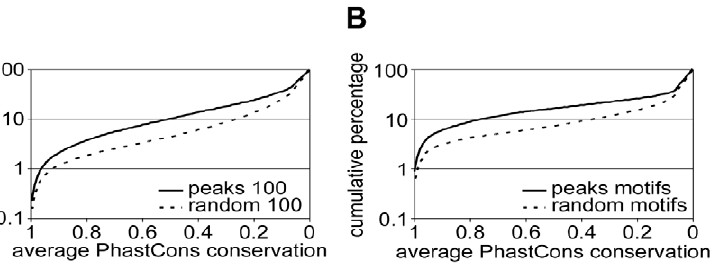
Figure 2. Conservation of p63 binding sites and motifs in vertebrates. The percentage of p63 binding sites (y-axis) is plotted against decreasing cut-off values of the PhastCons Conservation Score (PCCS) (x-axis). A point on the line indicates the percentage of binding sites with that particular PCCS or higher. (A) Average PCS of 100-nucleotide regions centered at the summit of 11,425 p63 binding peaks (peaks 100) and that of 100,000 100nt regions randomly chosen from the whole genome (random 100). (B) Average PCCS of 10,659 10-nt p63 motifs detected by p63scan in the 11,425 p63 binding peaks (peaks motifs) and of the 7,600 motifs detected in 100,000 random genomic regions (random motifs).